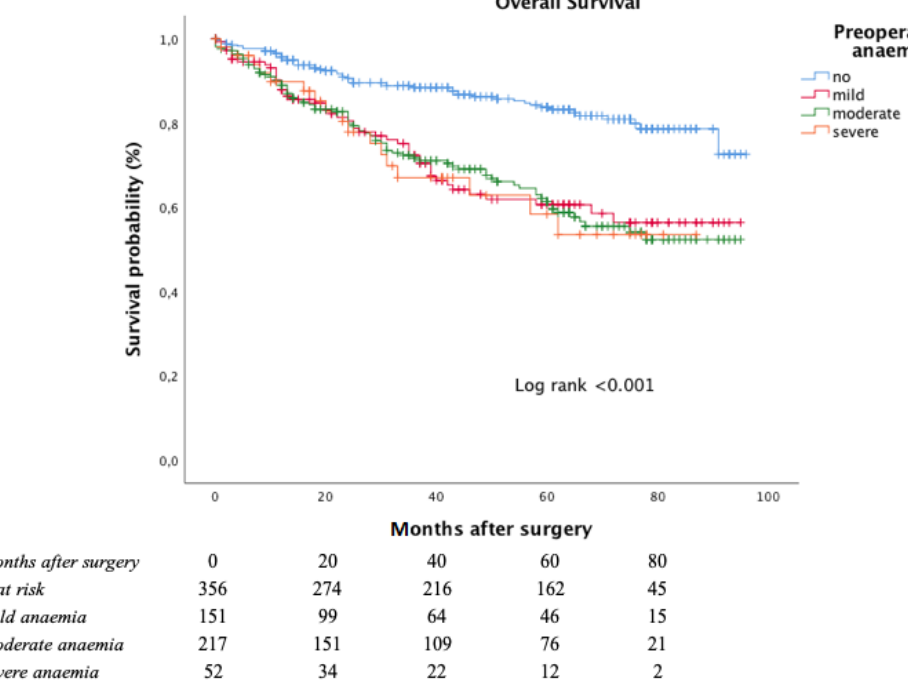
Figure 2. Overall survival according to anaemia severity at admittance.